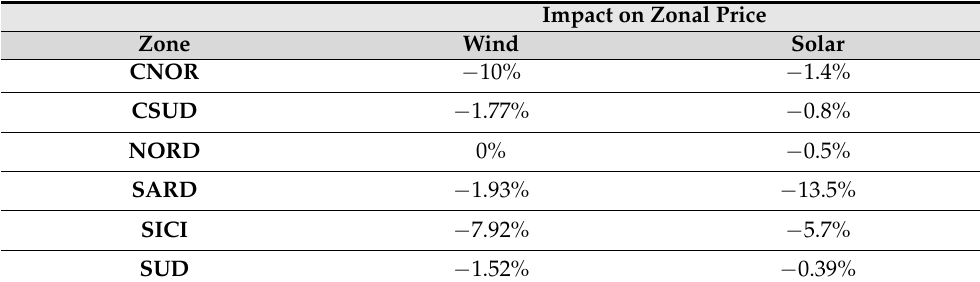
Table 3. Impact of 100 MW increases in wind and solar generation on different zonal price; percent of average zonal price in 2019.